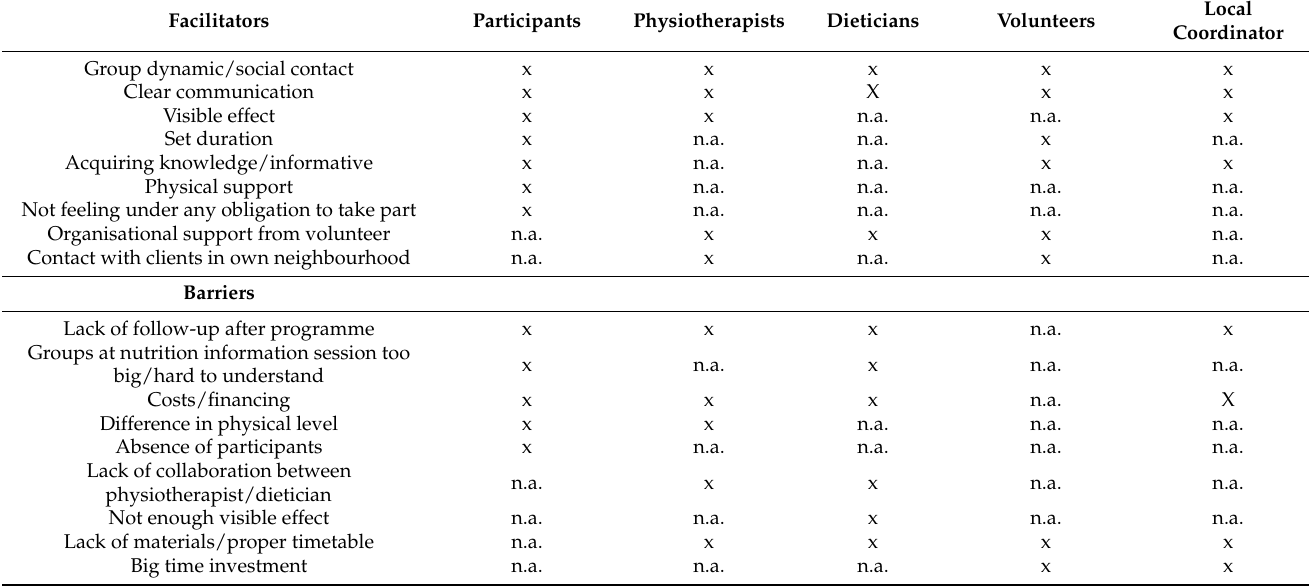
Table 3. Facilitators and barriers of